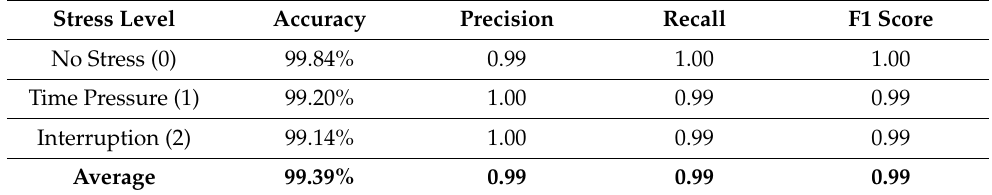
Table 4. Overall performance results attained by the proposed image ‐ encoding ‐ based deep neural network on both WESAD and SWELL datasets.